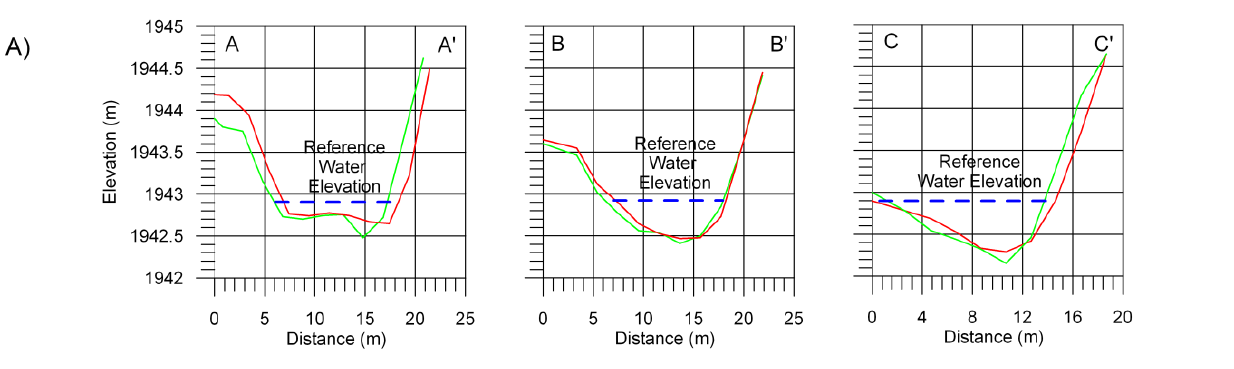
Figure 8. Bathymetric LIDAR and ground survey comparison at a straight channel reach. (A) Example cross sections at locations shown in map view: black = ground survey, green = LIDAR survey; (B) Map view comparison. The contours are from ground survey data. The colored intervals are elevation differences calculated as ground survey grid node elevation minus LIDAR grid node elevation. These colored intervals are georeferenced to the contour map and show that the largest errors tend to occur along the stream banks. The dashed line is the location of channel elevation profile; (C) Channel elevation profiles: black = ground survey points (most accurate), red = profile through ground survey raster, green = profile through LIDAR